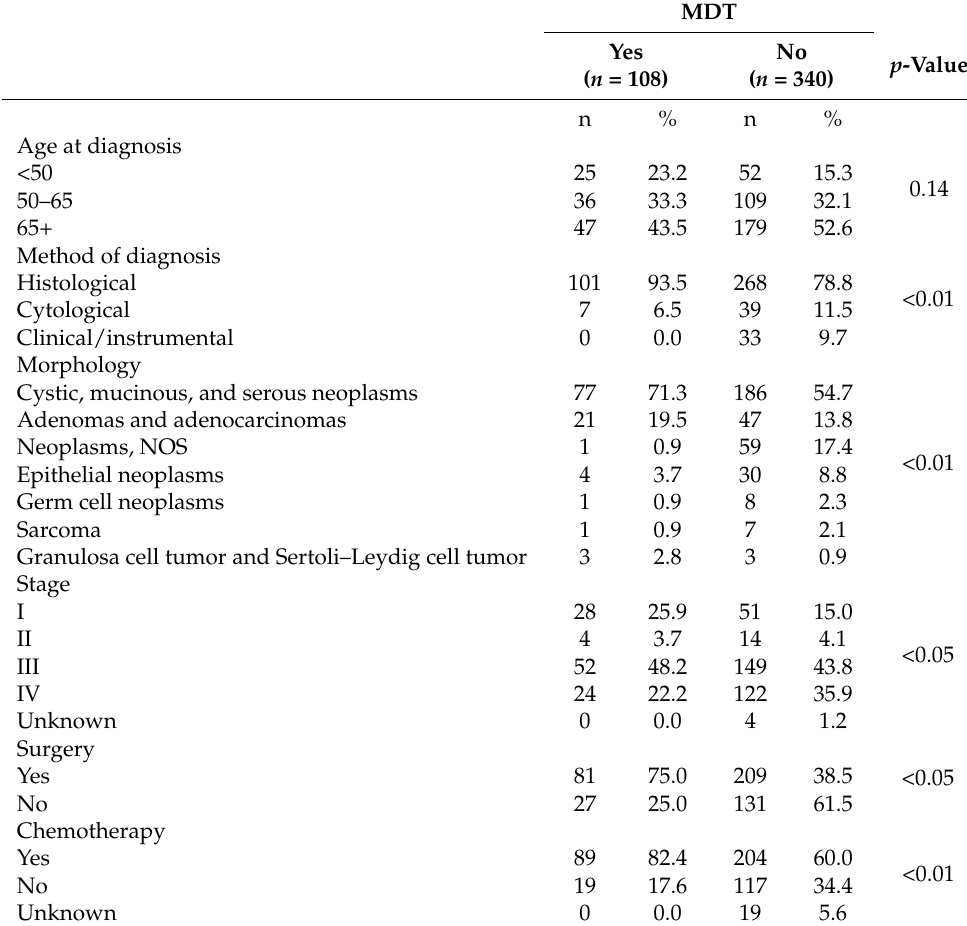
Table 3. Distribution of cases by age, diagnosis, stage, and treatment for MDT